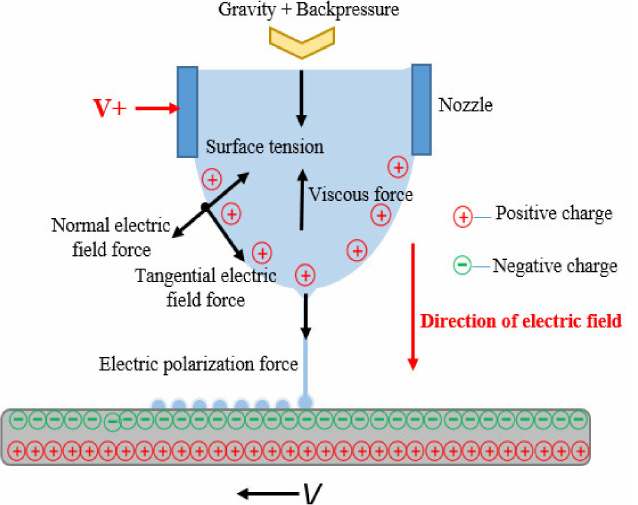
Figure 1. Schematic diagram of the principle of high-voltage electric field-driven jet deposition on